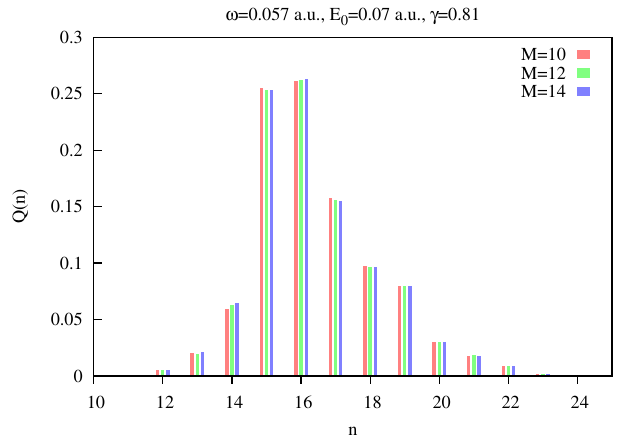
Figure 4. Absorbed photons probability distributions Q n , obtained for different propagation intervals in Eq. (11) for an effective field strength of 0.07